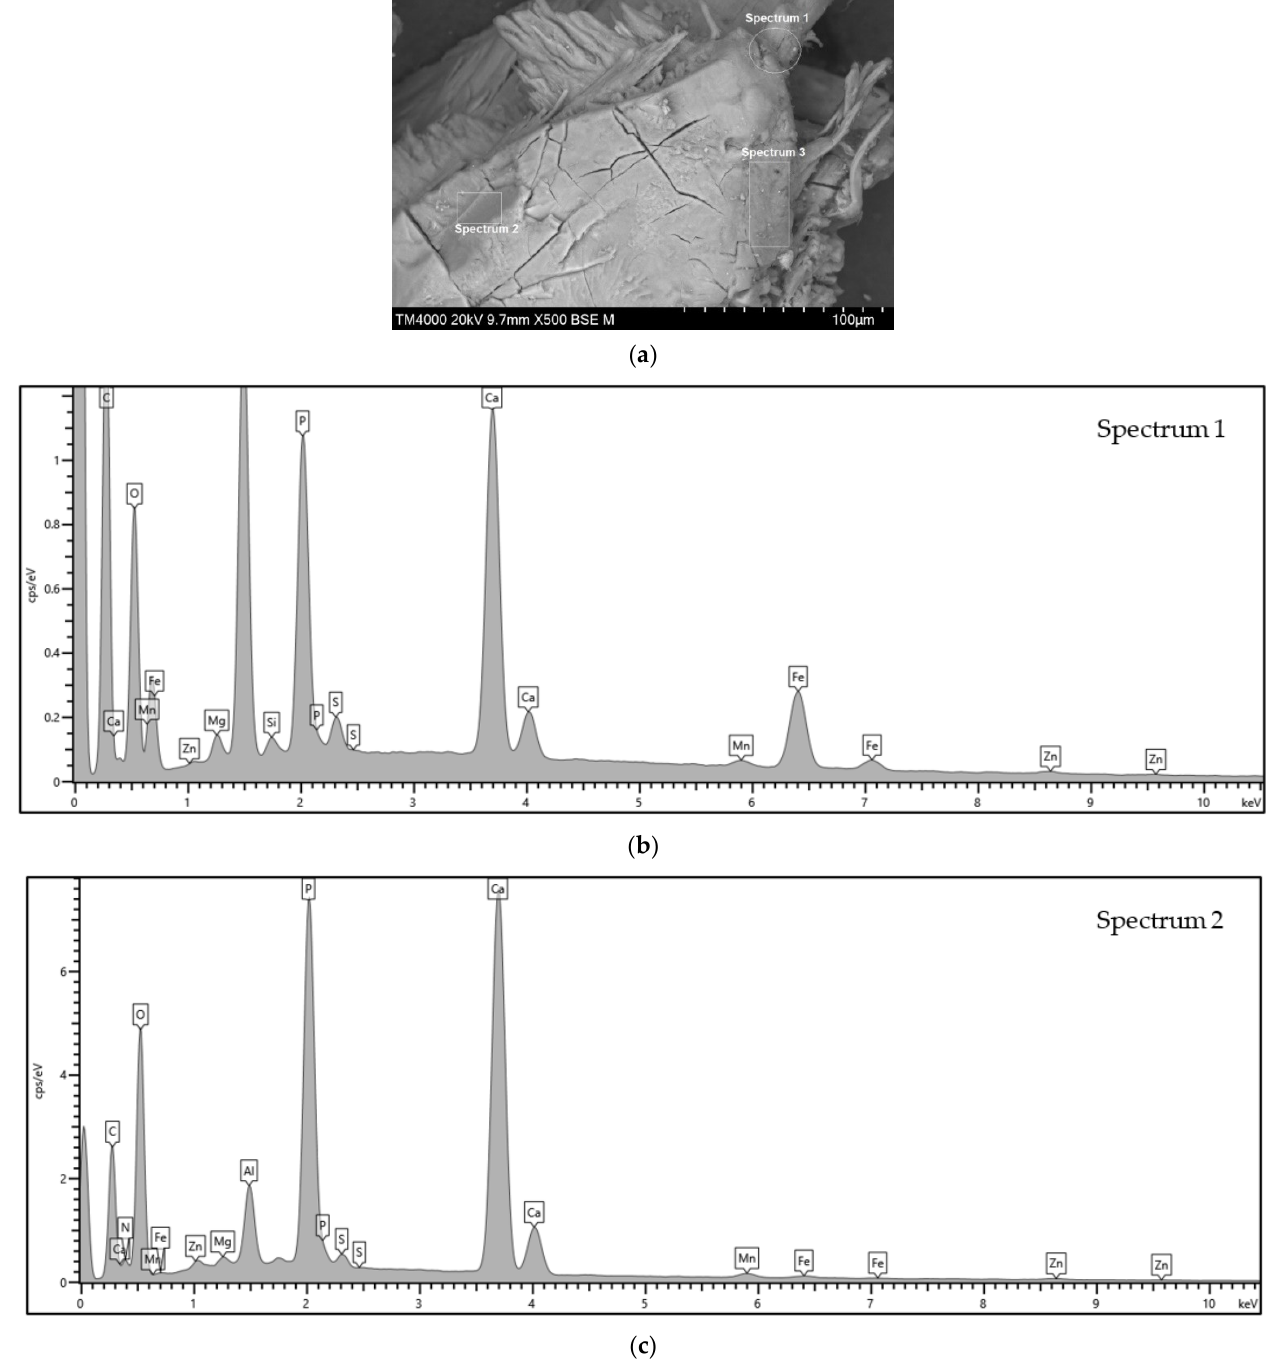
Figure 6. SEM micrograph of the powder fish scales after 240 min of contact with AMD solution ( a ); EDX spectra corresponding to the three regions identified on the surface of the scales: ( b ) whiter—spectrum 1 and ( c ) darker—spectrum 2.